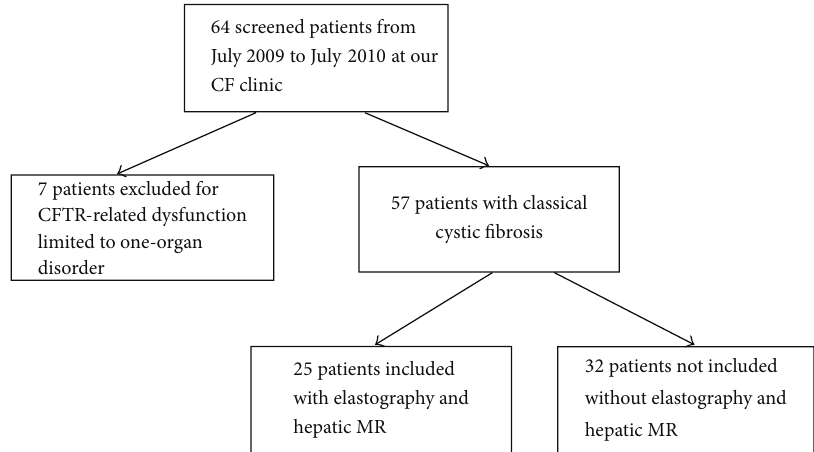
Figure 1: Flow chart for inclusion in our study.